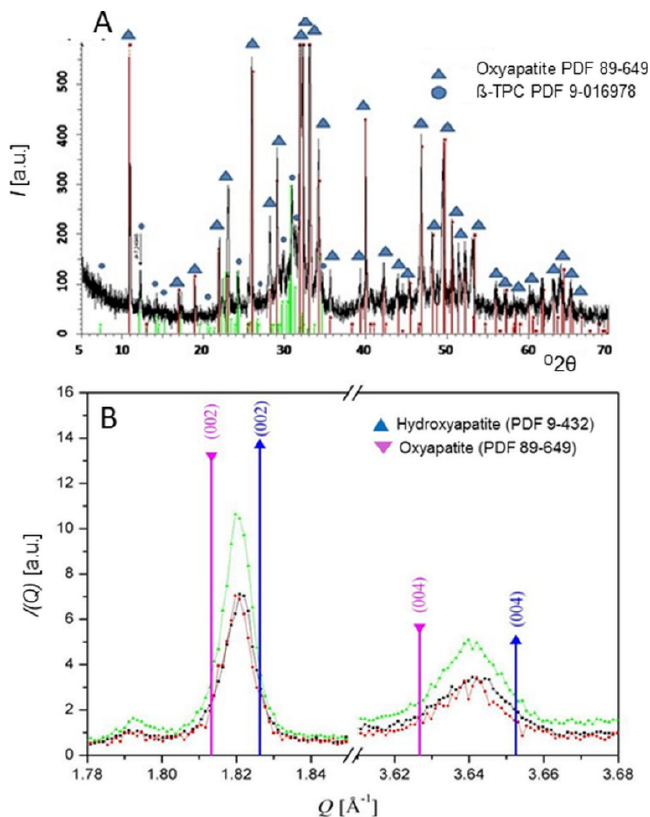
Figure 4. ( A ): High-resolution synchrotron radiation diffraction pattern of HAp coatings, deposited with low plasma power of 11 kW, show mainly oxyapatite with minor contribution of ß-tricalcium phosphate [38]. Additional plasma spray parameters were selected as follows: plasma gas (argon) flow rate 50 slpm, powder feed rate 18 g/min, spray distance 100 mm, and translation speed 30 m/min. ( B ): Scattering vectors Q (= 4 π × sin θ / λ ) of the diffraction profiles of three plasma-sprayed HAp coatings around (00.2) and (00.4) interplanar spacings of HAp (blue) and OAp (pink). Synchrotron radiation obtained from Angströmquelle Karlsruhe GmbH (ANKA), λ = 0.95 Å; step size 0.05 o 2 θ ; range 2.0–52 o 2 θ . © Reprinted with permission from R.B. Heimann, Materialwiss.